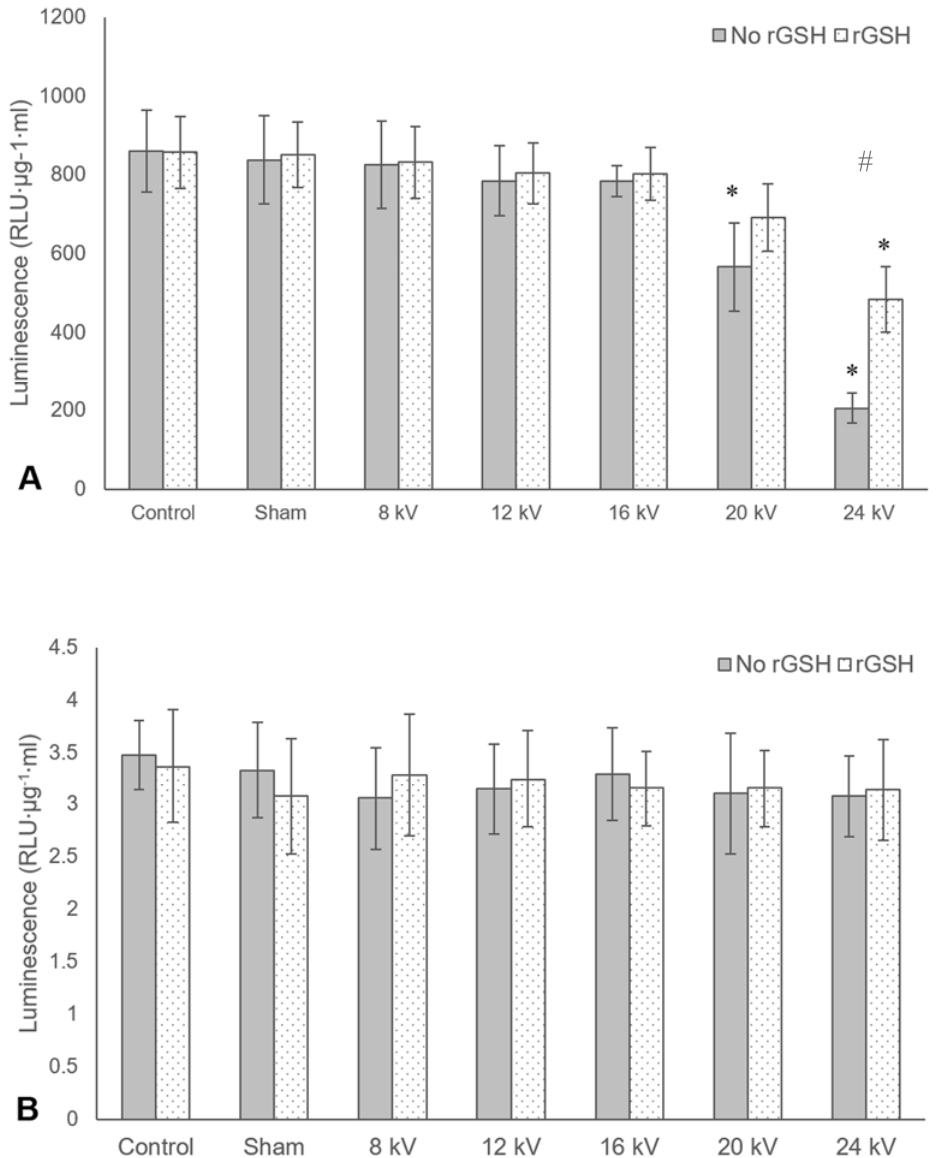
Figure 3. Mean average luminescence, represented as relative light units adjusted for protein concentration, measured after lysis of cells incubated with either electrosprayed MVA ( A ) or Ad ( B ) with or without the presence of rGSH. Working distance: 7.25 cm, flow rate: 10 µ L / min. Error bars represent the standard deviation, n = 3. Two-way ANOVA and Tukey–Kramer post-hoc tests were used to make statistical comparisons. A p -value of less than 0.05 was considered statistically significant. A single asterisk indicates significance compared to respective group control, a hash symbol indicates significance within a given voltage.